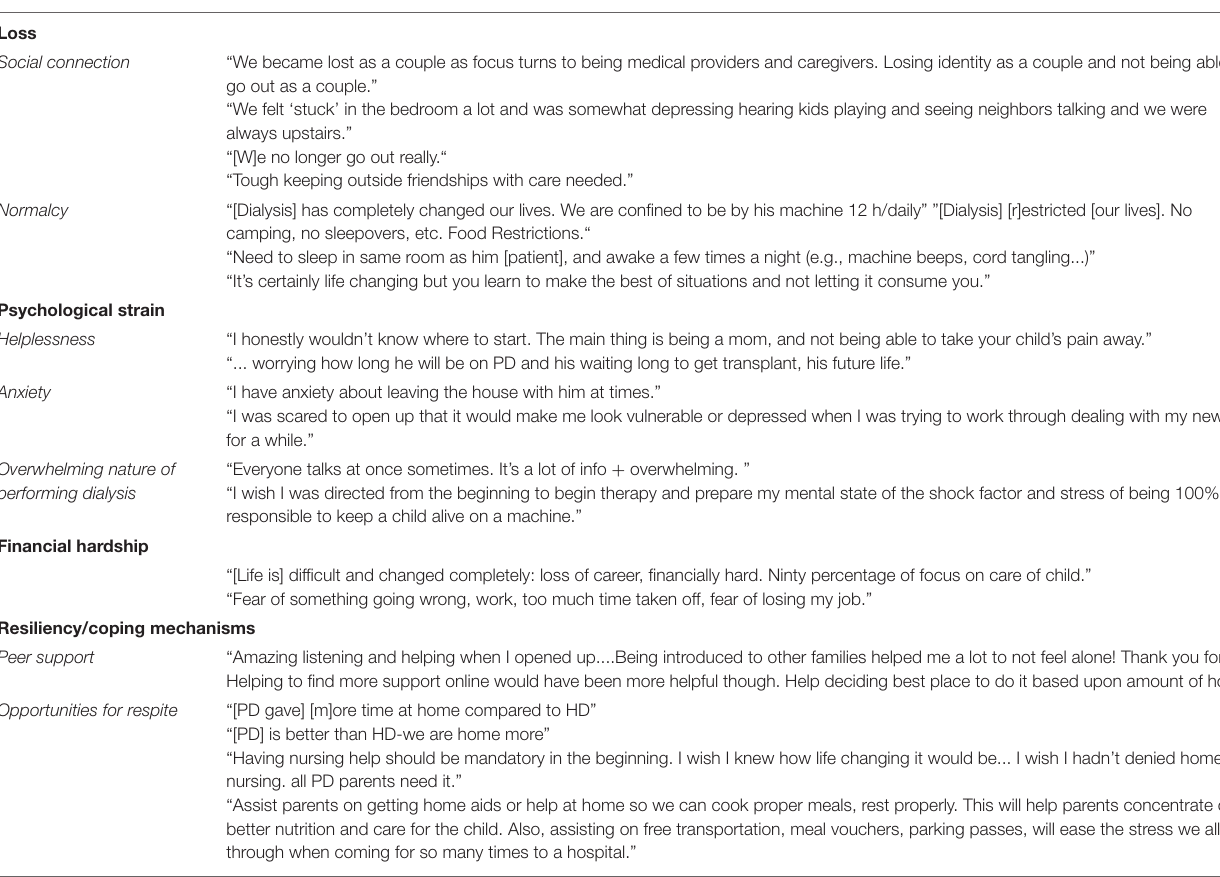
TABLE 4 | Themes and subthemes of pediatric caregiver reported